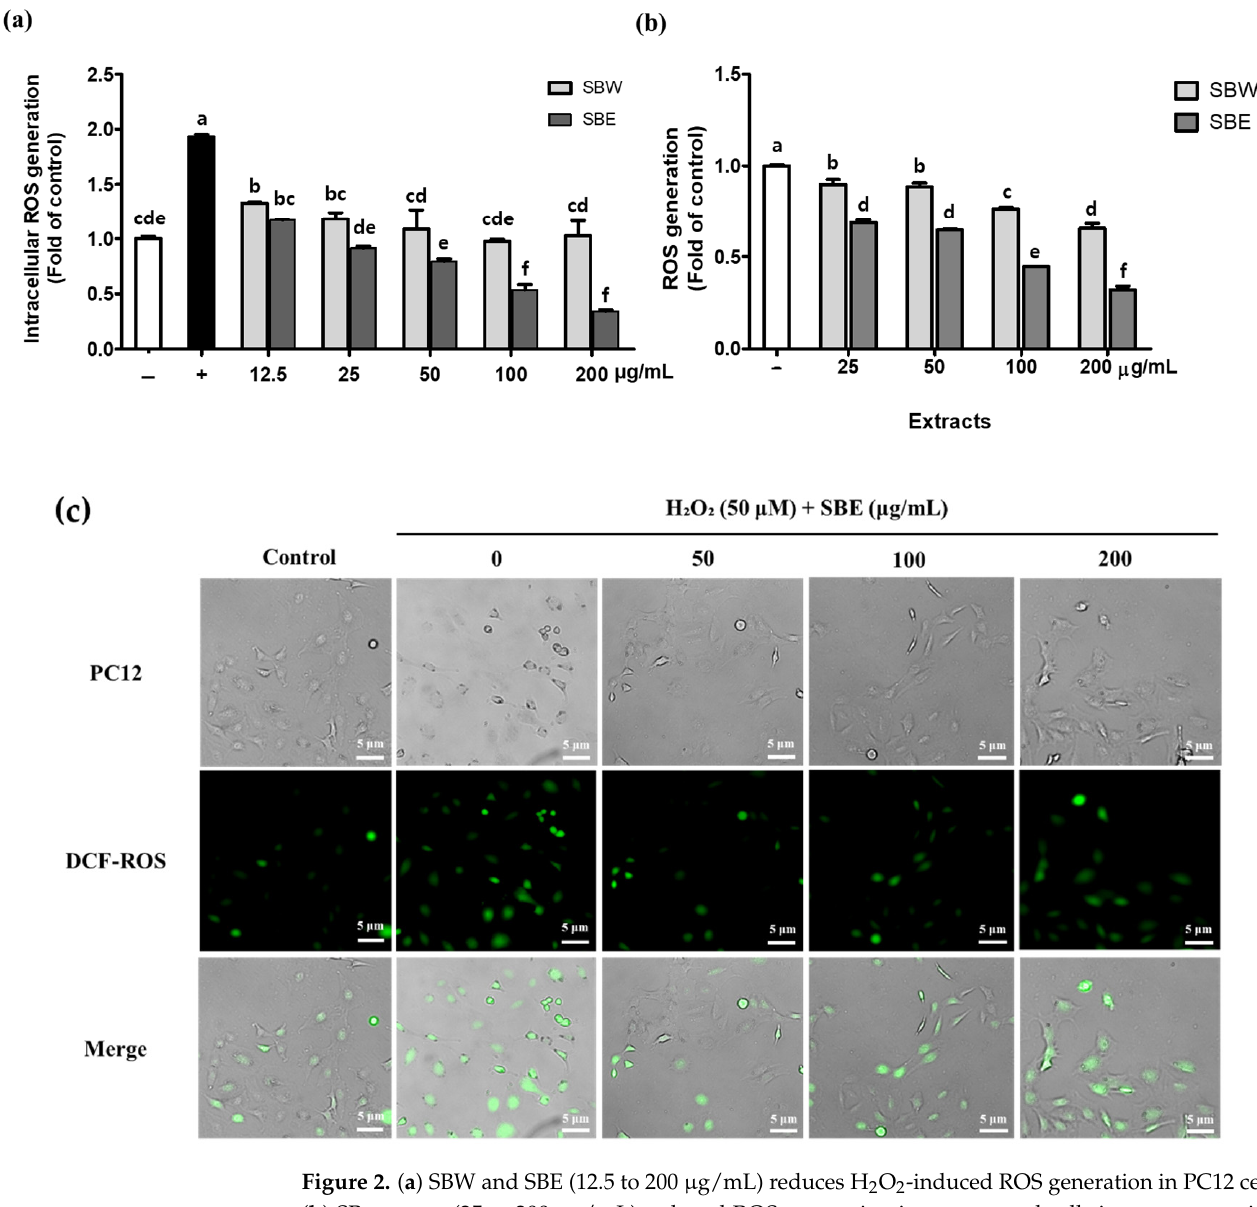
Figure 2. ( a ) SBW and SBE (12.5 to 200 µg/mL) reduces H 2 O 2 -induced ROS generation in PC12 cells. ( b ) SB extracts (25 to 200 µg/mL) reduced ROS generation in non-treated cells in a concentration- dependent manner. Negative control (-) means untreated group. SBW, Sasa borealis water extract; SBE, Sasa borealis ethanol extract. Data are expressed as mean ± SD (n = 3). Lowercase letters represent statistical differences at p < 0.05. ( c ) Cells were cultured with SBE (50–200 µg/mL) and H 2 O 2 (50 µM) and stained with DCF-DA. H 2 O 2 -induced ROS production in PC12 cells was visualized by flu- orescence microscopy. Scale bar, 5 µm.